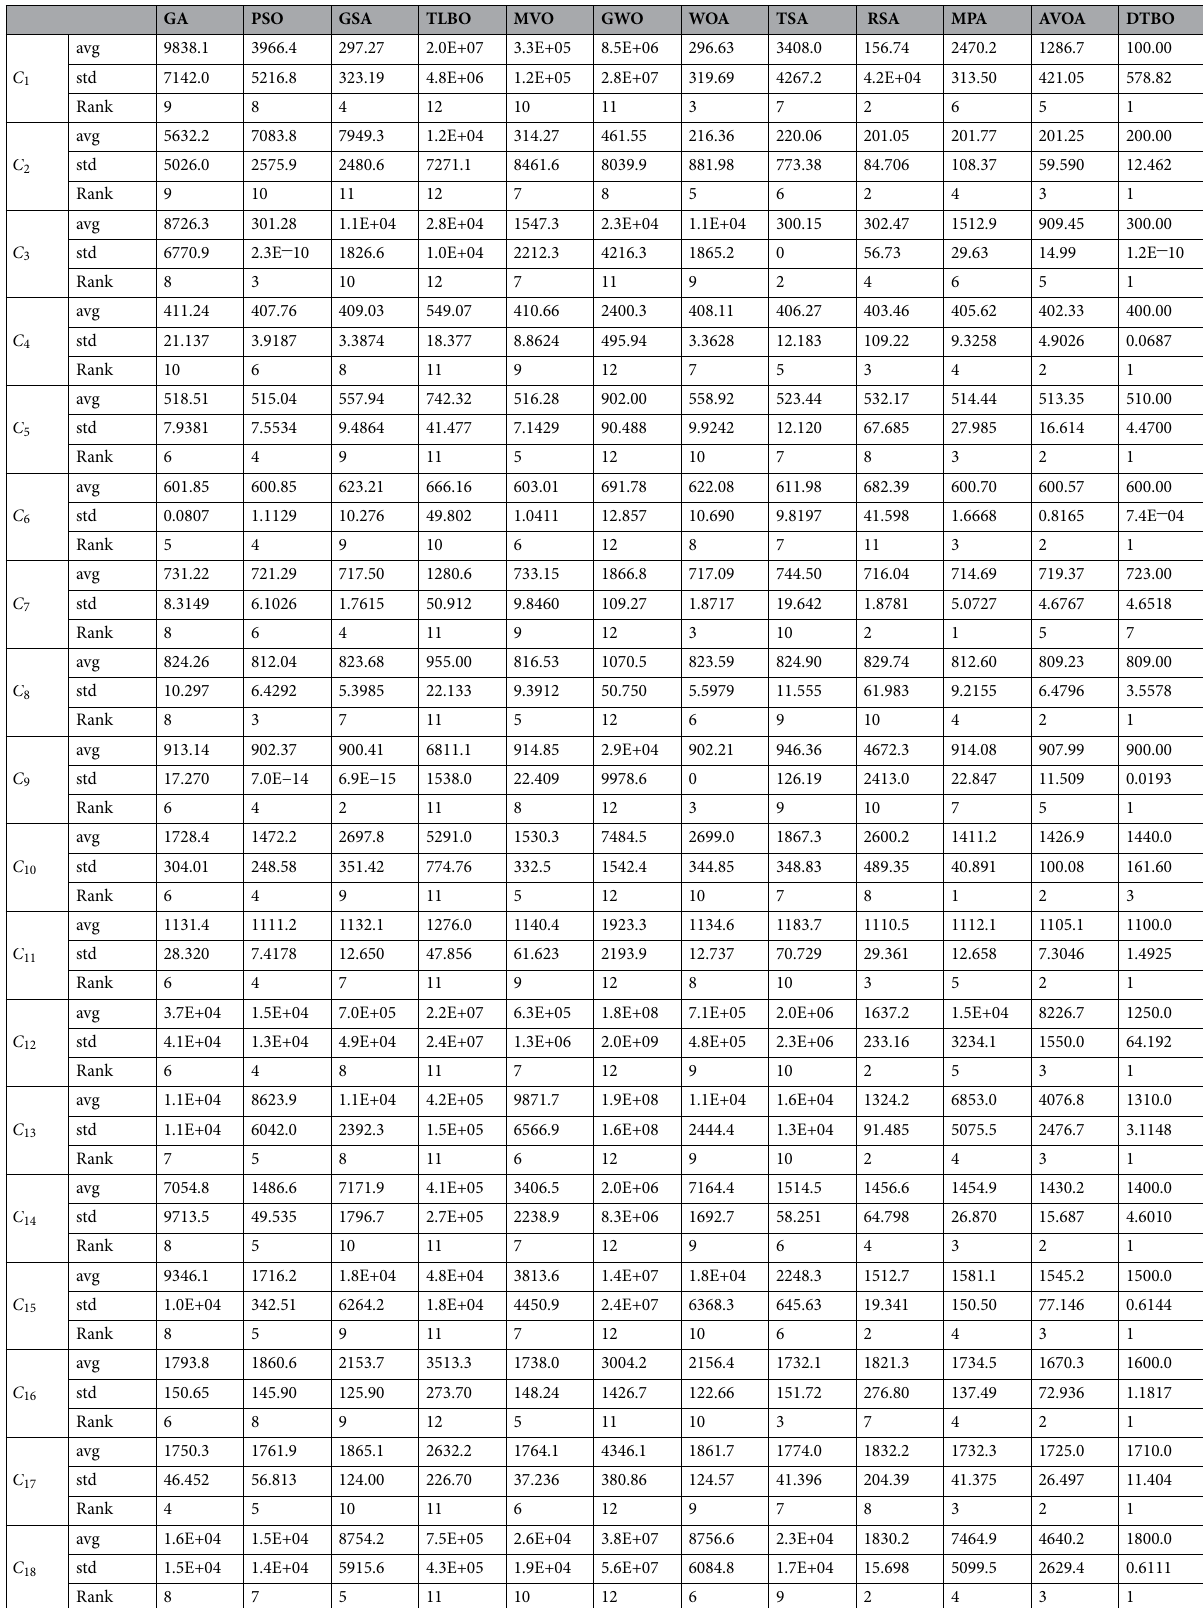
Table 5. Evaluation results of IEEE CEC 2017 objective functions C 1 to C 18